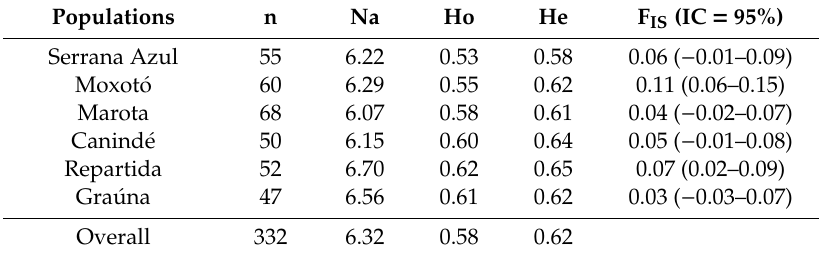
Table 1. The number of samples (n), the average number of alleles (Na), average observed heterozygosity (Ho), the average expected heterozygosity (He), and F IS values of the Brazilian breeds. Populations n Na Ho F IS (IC = 95%)